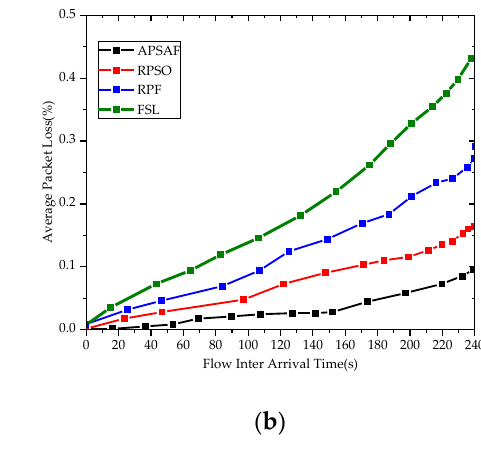
Figure 10. ( a ) Packet Loss. ( a ). Packet Loss.